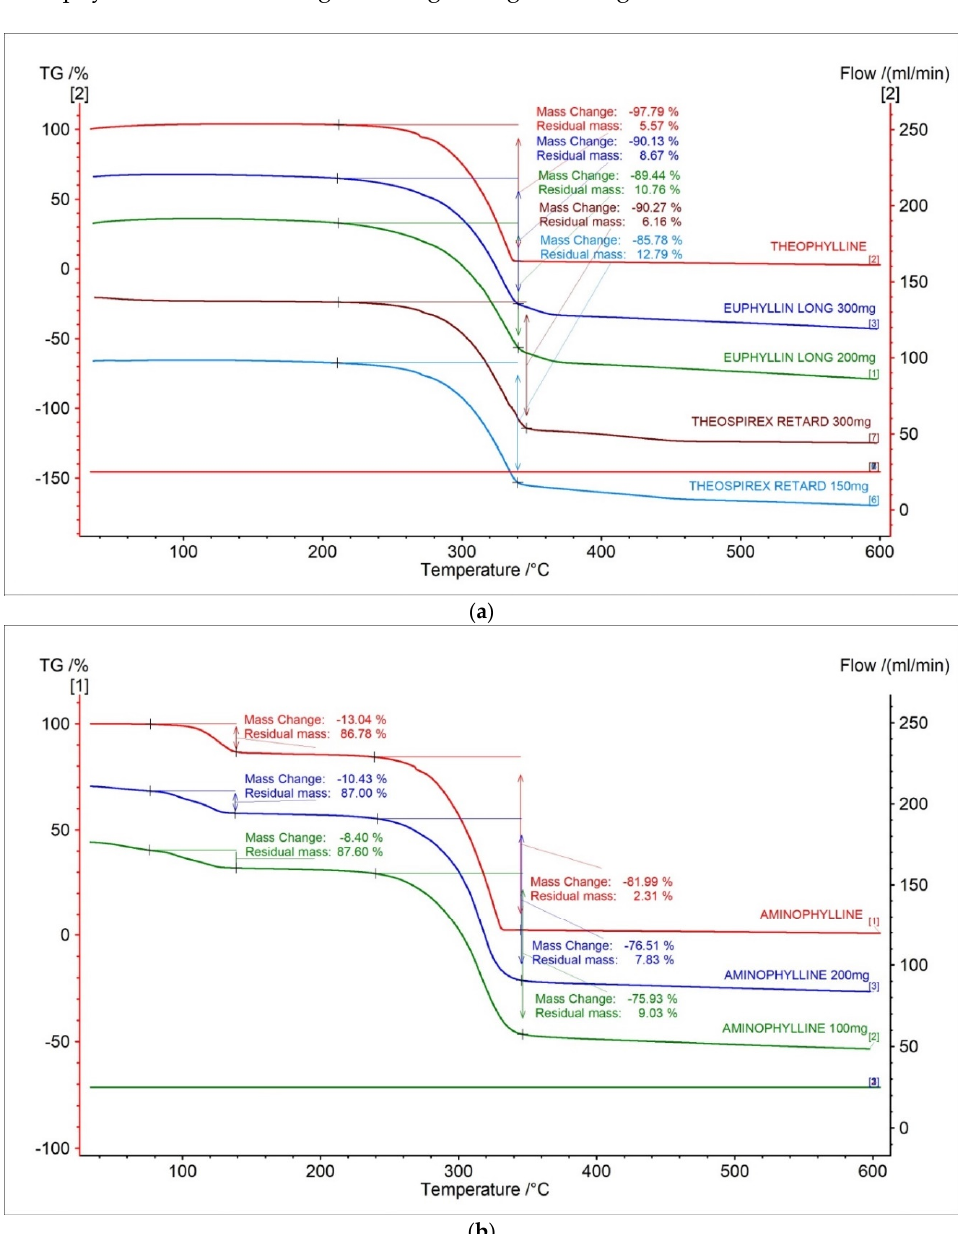
Figure 2. TG curves for ( a ) theophylline standard, ( b ) aminophylline, and pharmaceutical prepara- tions containing theophylline and aminophylline.